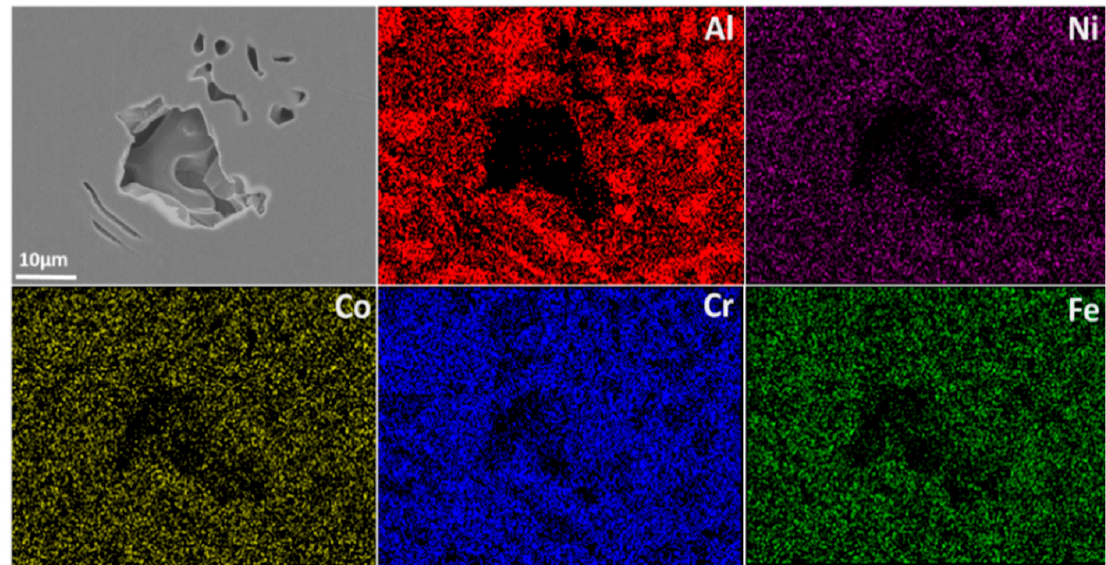
Figure 13. EDS of local corrosion on AlCoCrFeNi 2.1 in chloride-containing sulfuric acid solution at 5 ℃ .